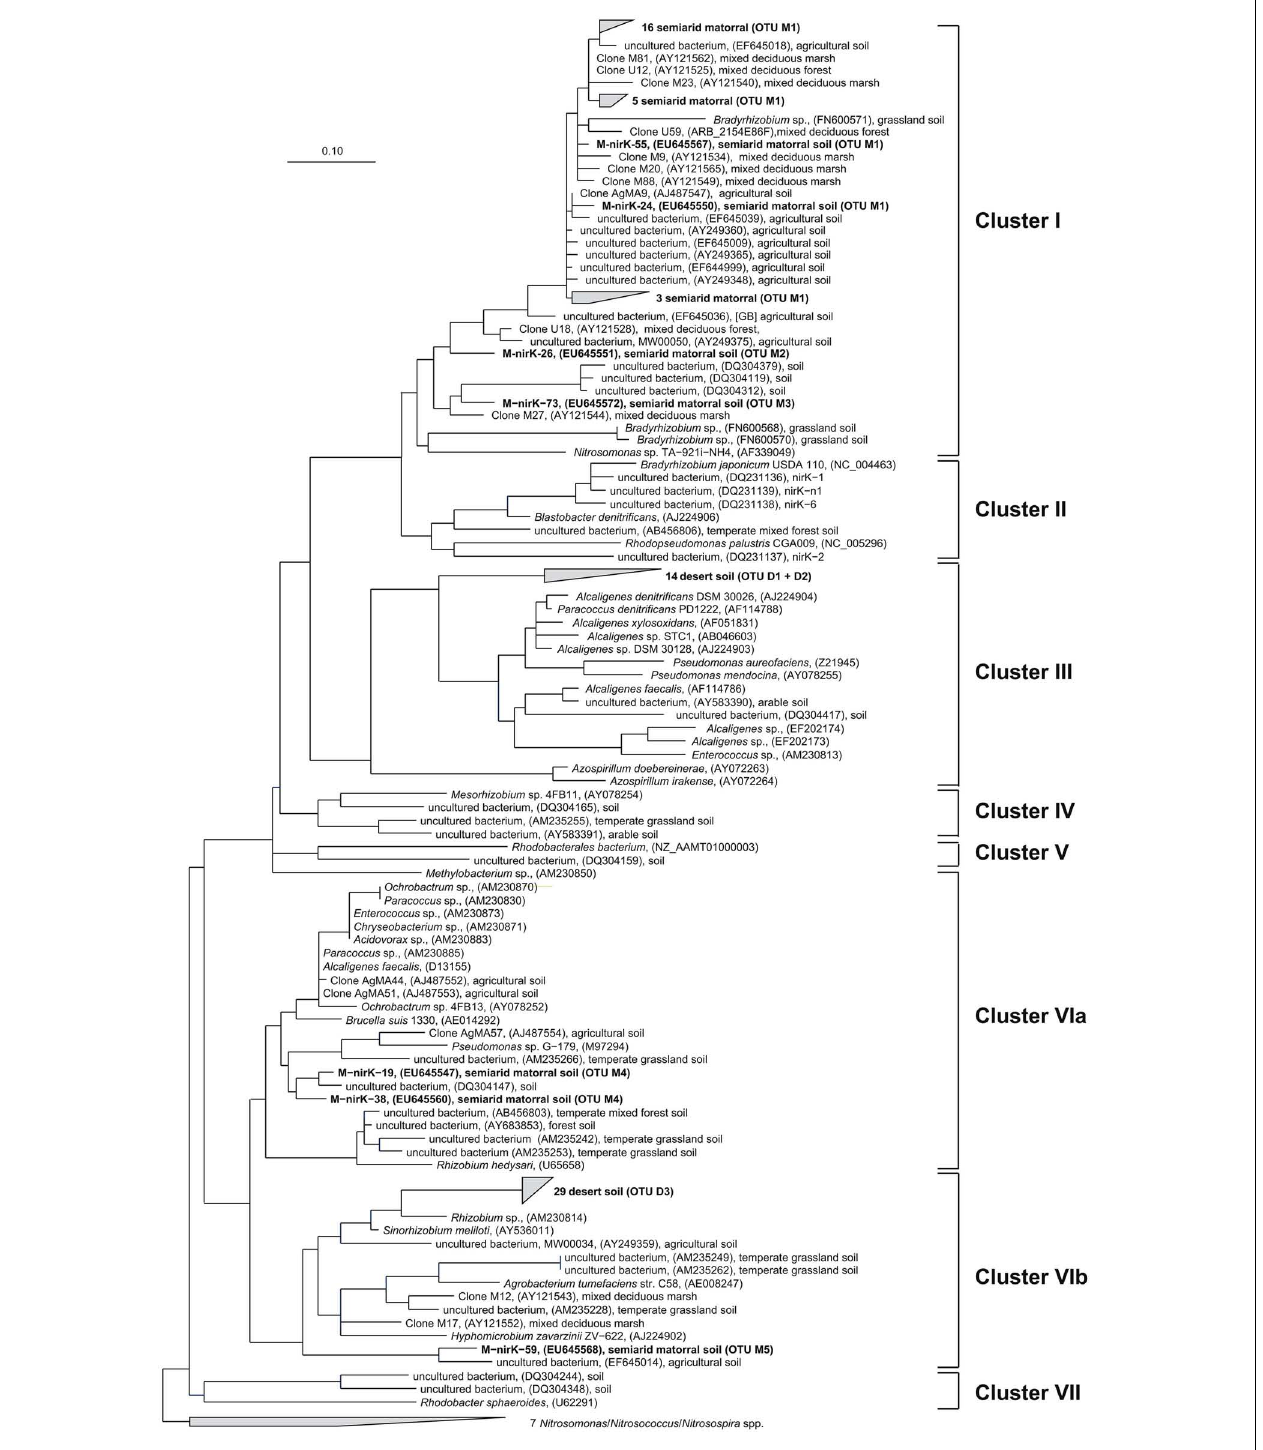
FIGURE 2 | Neighbor joining tree (Kimura amino acid replacement model) based on 134 deduced amino acid positions of nirK -gene sequences retrieved from soil samples of the sclerophyllous